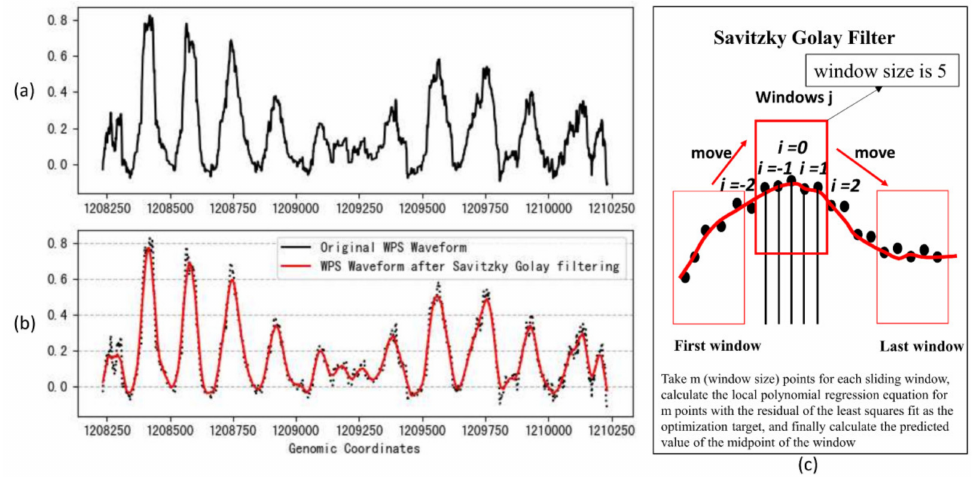
Figure 8. ( a ) WPS waveform before filtering; the red curve in ( b ) the waveform after SG filtering. ( c ) The algorithm principle of the SG